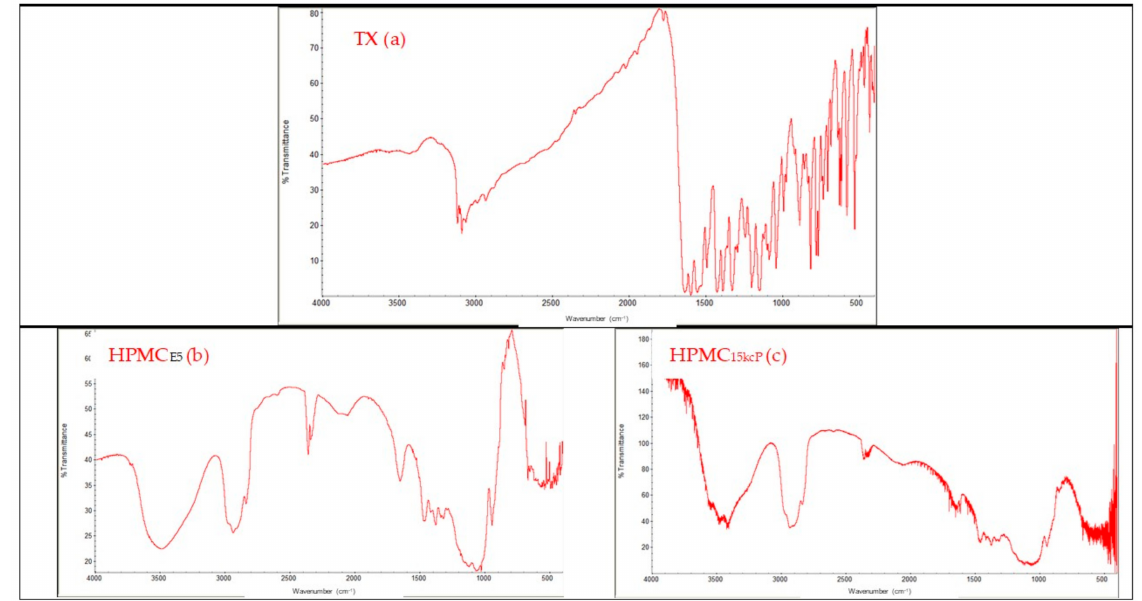
Figure 1. The FT-IR spectra of: TX ( a ), HPMC E5 ( b ), and HPMC 15kcP ( c